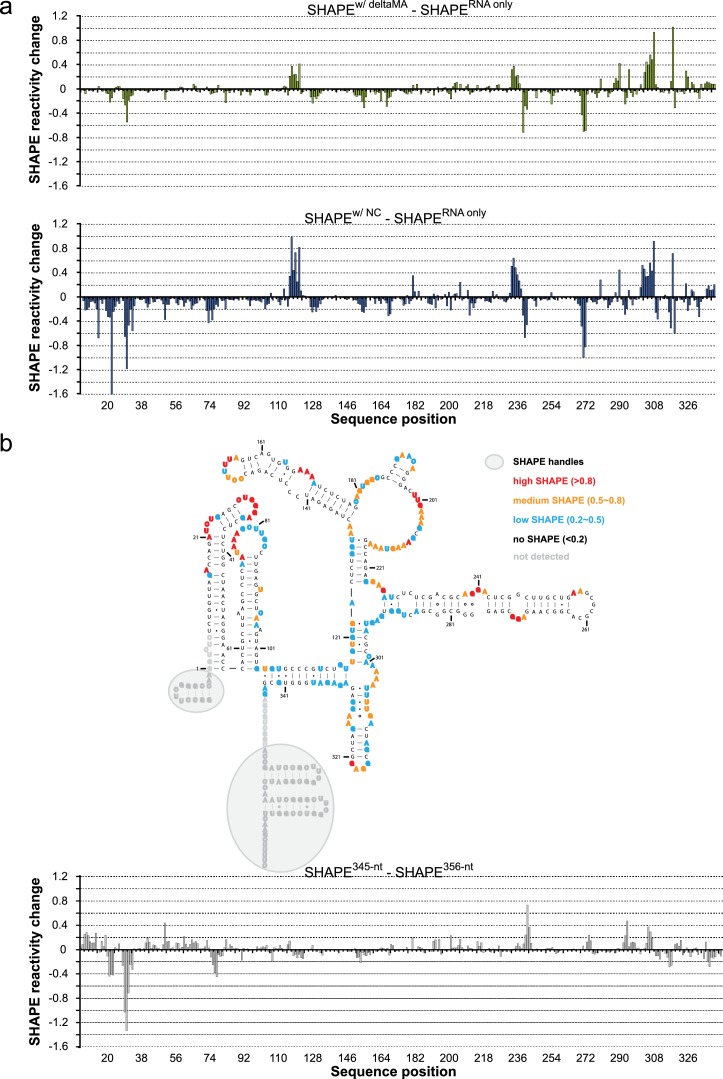
SHAPE changes for protein addition in solution and a longer 5’UTR RNA.(a) Changes in SHAPE reactivity are plotted as in Figure 4c, for addition of ΔMA-Gag and NC, respectively, and between a longer 356 nt 5’UTR and the 345 nt 5’UTR used throughout the study. (b) Secondary structure of the 356-nt HIV 5’UTR RNA with SHAPE reactivities labeled as in Figure 4a.